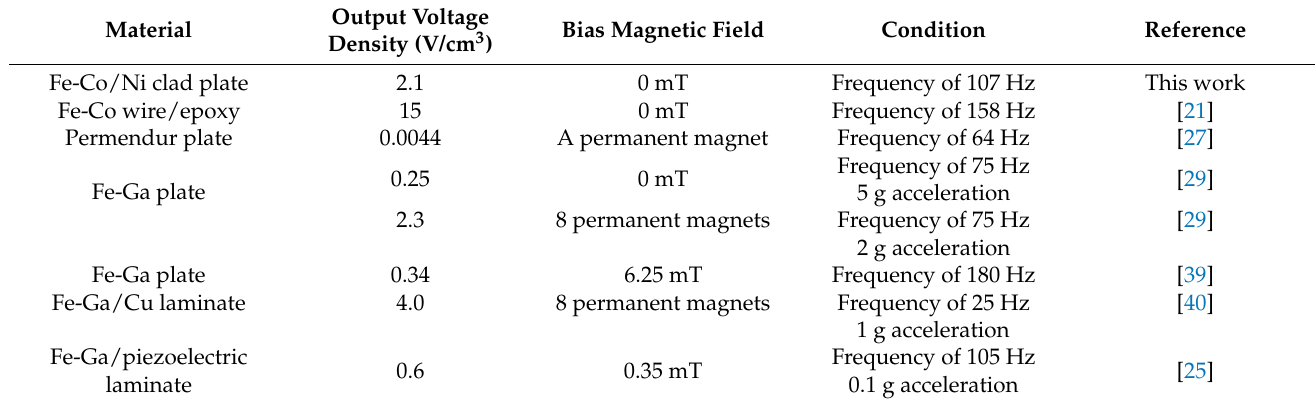
Figure 4. Measured and calculated frequency shift versus load or weight.